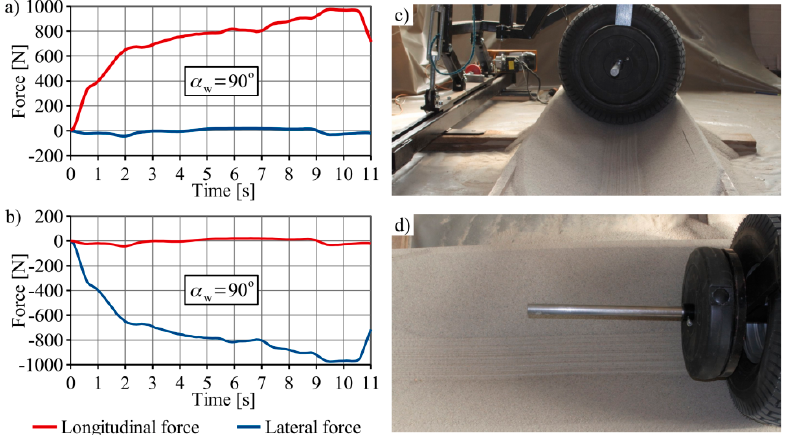
Figure 6. Graph of the measured longitudinal and lateral forces relative to the direction of move- ment ( a ), as well as the calculated longitudinal and lateral forces relative to the geometry of the wheel ( b ), for α w = 90°. The wheel on the experimental stand after the test ( c ), and the resulting tire track ( d ) [21].